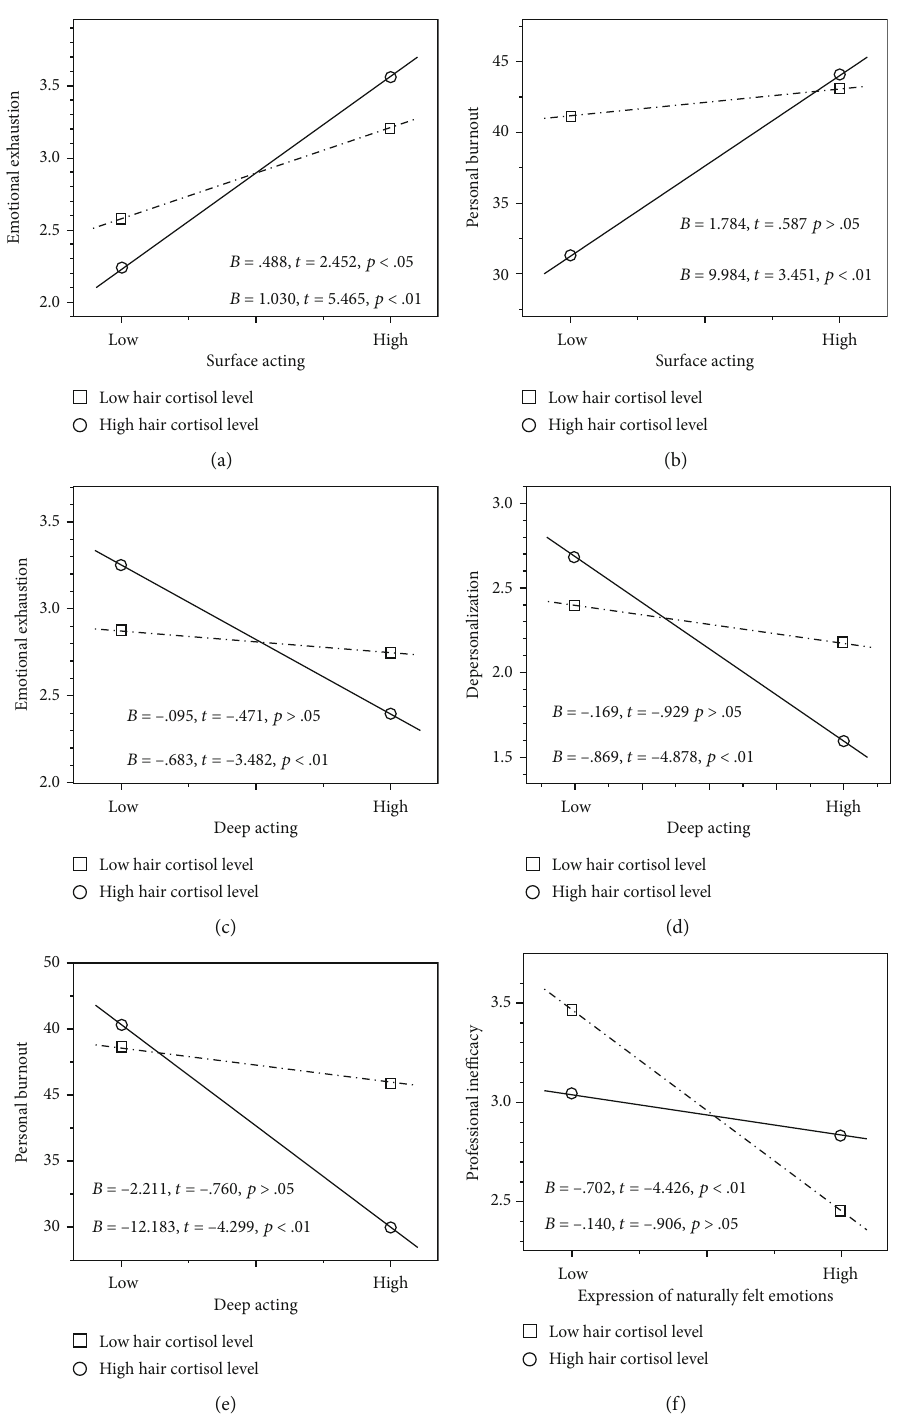
Figure 1: The moderating role of hair cortisol in the relationship between emotional labor strategies and job burnout: (a) surface acting and emotional exhaustion, (b) surface acting and personal burnout, (c) deep acting and emotional exhaustion, (d) deep acting and depersonalization, (e) deep acting and personal burnout, and (f) expression of naturally felt emotions and professional ine ffi